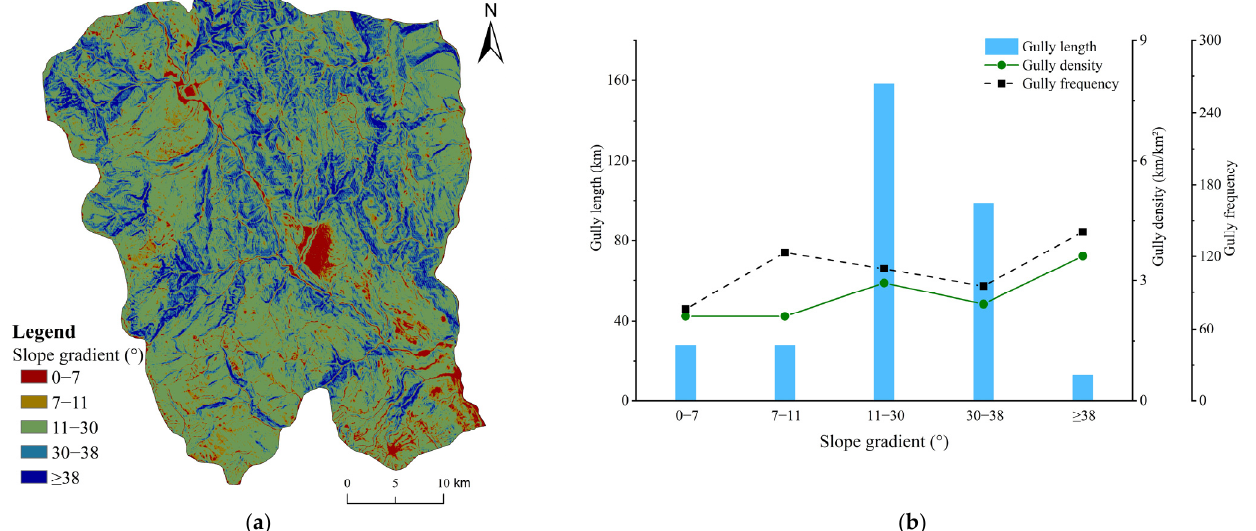
Figure 5. ( a ) Distribution of reclassified slope gradient ranges; ( b ) Characteristics of gully system parameters (gully length, density, and frequency) under different slope gradient ranges.